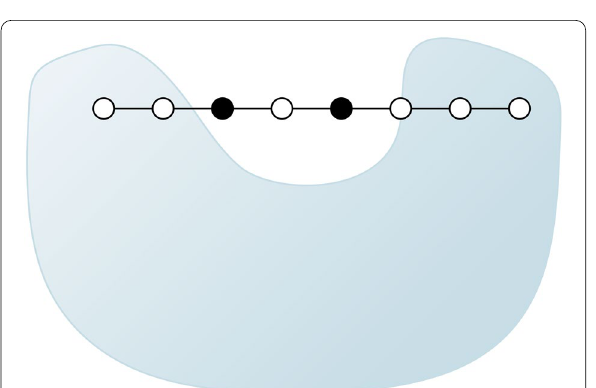
Figure 4 Process of Algorithm 2 (The non-solid circles are the invalid points, and the solid circles are the valid points. The solid circles are added to the set of points SP